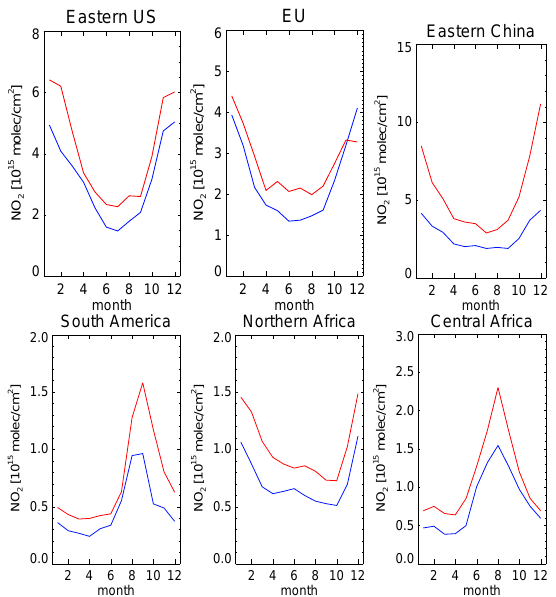
Fig. 10. Annual cycle of regionally and monthly averaged NO 2 tropospheric columns from TM5 (blue) against OMI (red).